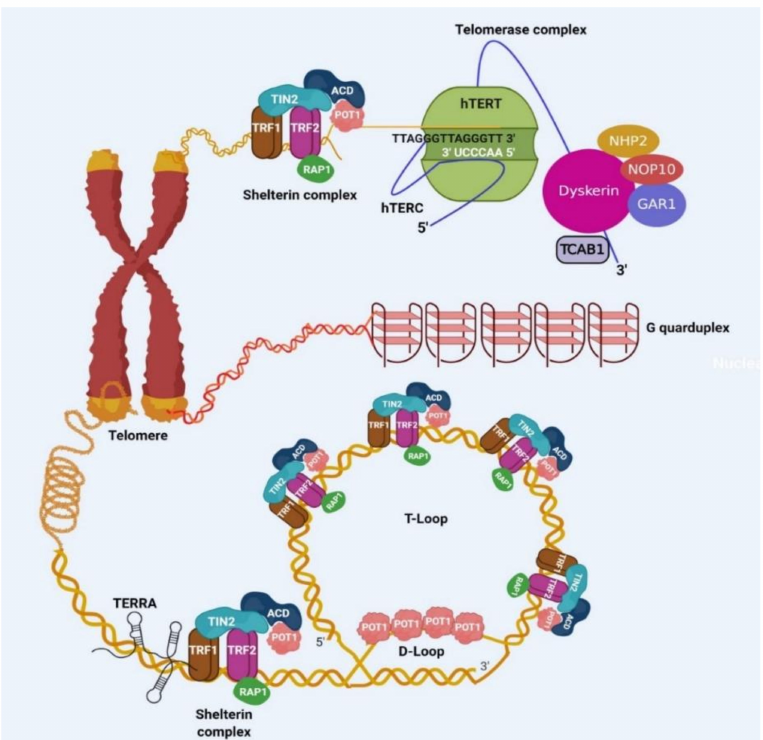
Figure 1. Schematic illustration of telomeric components. Shelterin complex comprising of the six members known as telomere repeat factor 1 (TRF1), telomere repeat factor 2 (TRF2), TRF interacting nuclear protein 2 (TIN2), repressor / activator protein 1 (RAP1), adrenocortical dysplasia protein homolog (ACD), and protection of telomere 1 (POT1), present at the telomeres. This complex directly binds to double-stranded telomeric DNA and is crucial for safeguarding the telomeres, as well as controlling th telomerase activity during elongation of telomeres. The telomerase is a complex represented by three major components: (a) telomerase reverse transcriptase (TERT), (b) RNA component (TERC), and (c) dyskerin complex containing NHP2, NOP10, TCAB1, and GAR proteins. This complex elongates telomeres. Telomeric DNA is transcribed to generate telomeric RNA called TERRA. Telomeric DNA can form secondary structures such as T-loop, D-loop and